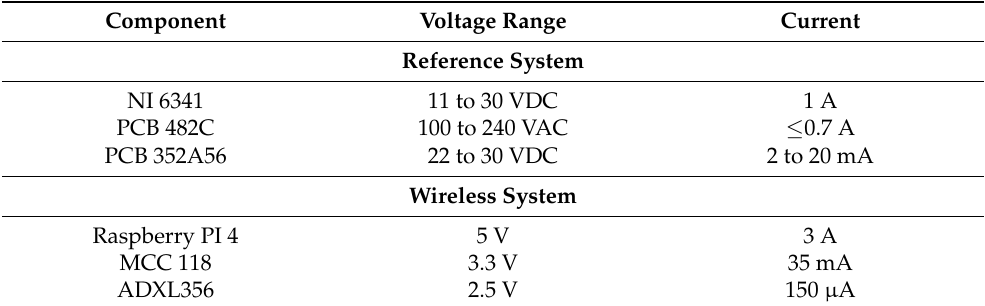
Table 4. Main power supply requirements for each considered vibration monitoring